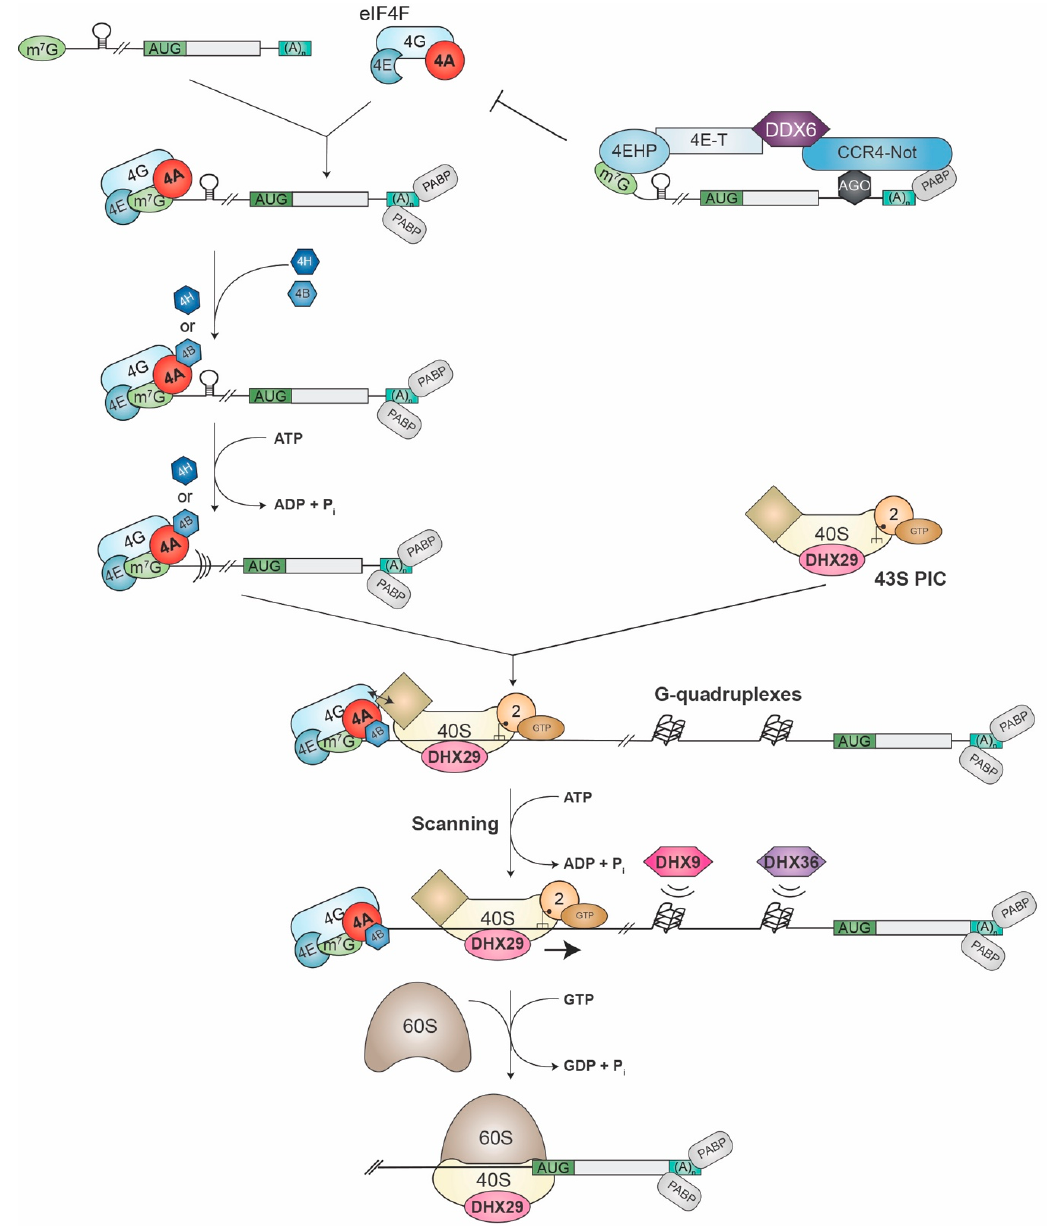
Figure 1. Schematic diagram of mammalian cap-dependent translation initiation pathway. See